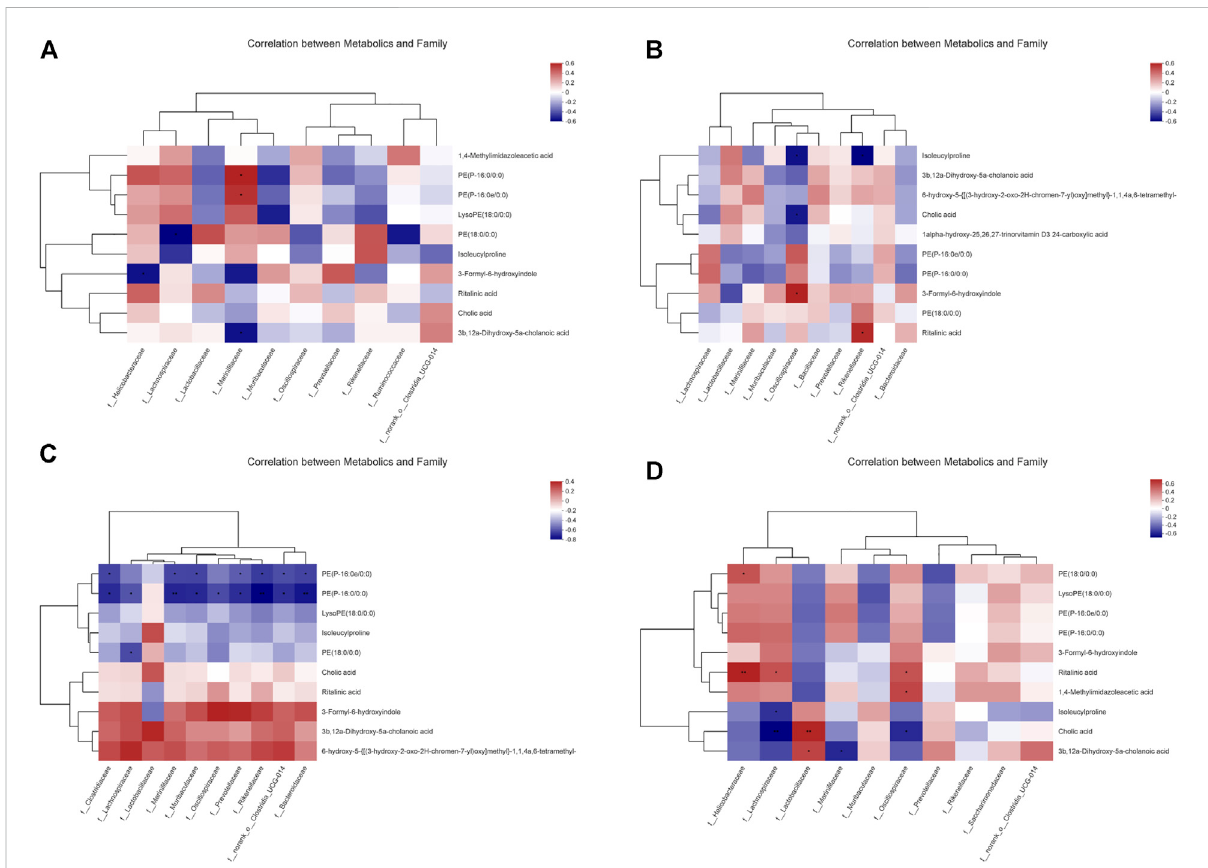
FIGURE 6 (A) Correlation between metabolics and family between the PCX and CNT group. (B) Correlation between metabolics and family between the PCY and CNT group. (C) Correlation between metabolics and family between the PCZ and CNT group. (D) Correlation between metabolics